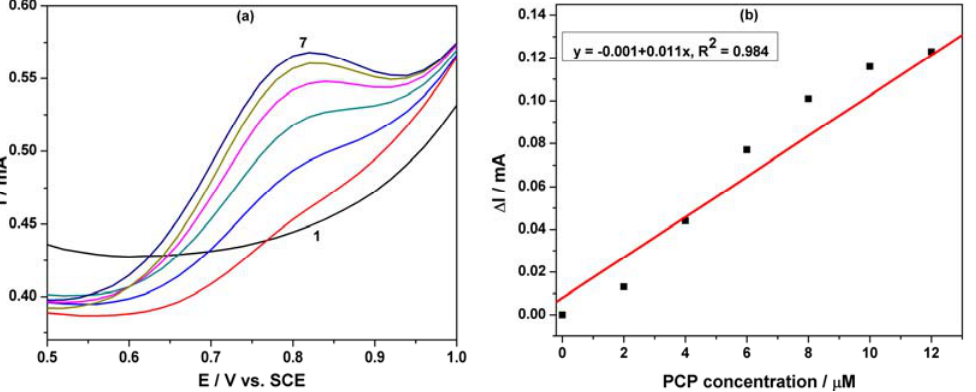
Figure 6. ( a ) DPVs of the MWCNT-EP composite electrode at (modulation amplitude 0.2 V, step potential 0.02 V) a potential scan rate of 0.05 Vs − 1 in the potential range between +0.5 V and +1.0 V vs . SCE in 0.1 M Na SO supporting electrolyte (curve 1) and in the 2 4 presence of different PCP concentration: (2) 2 µM; (3) 4 µM; (4) 6 µM; (5) 8 µM; (6) 10 µM; (7) 12 µM. ( b ) Calibration plot of the anodic currents recorded at E = +0.80 V/SCE vs . PCP